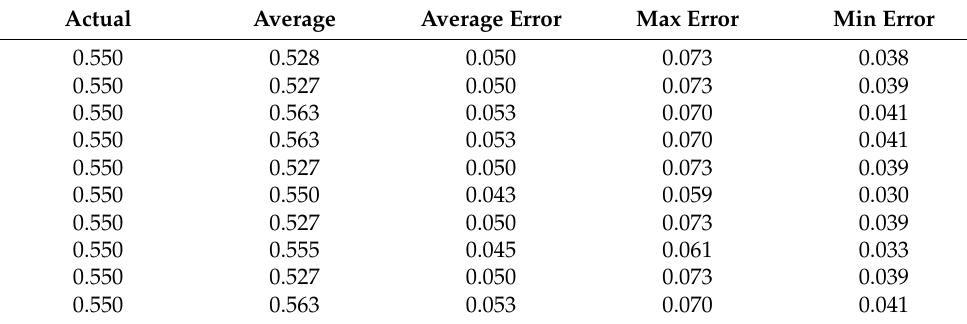
Table A65. Set 1, trials 41–50 data (all 0.5 PR values).